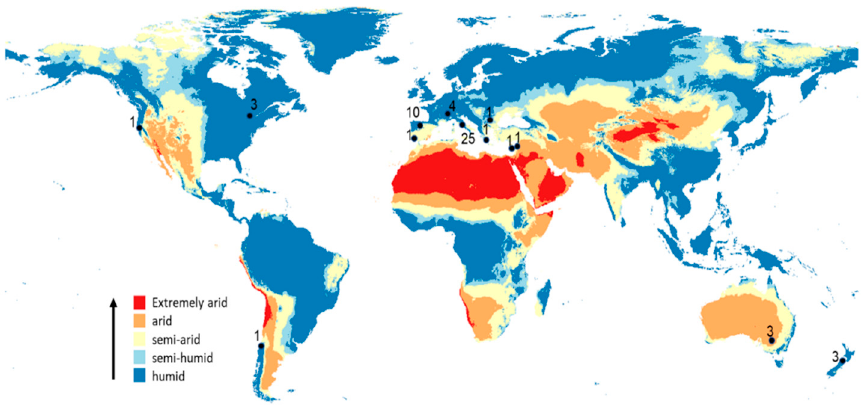
Figure 1. Selected studies that used the LCA method on a global aridity and transpiration index map.